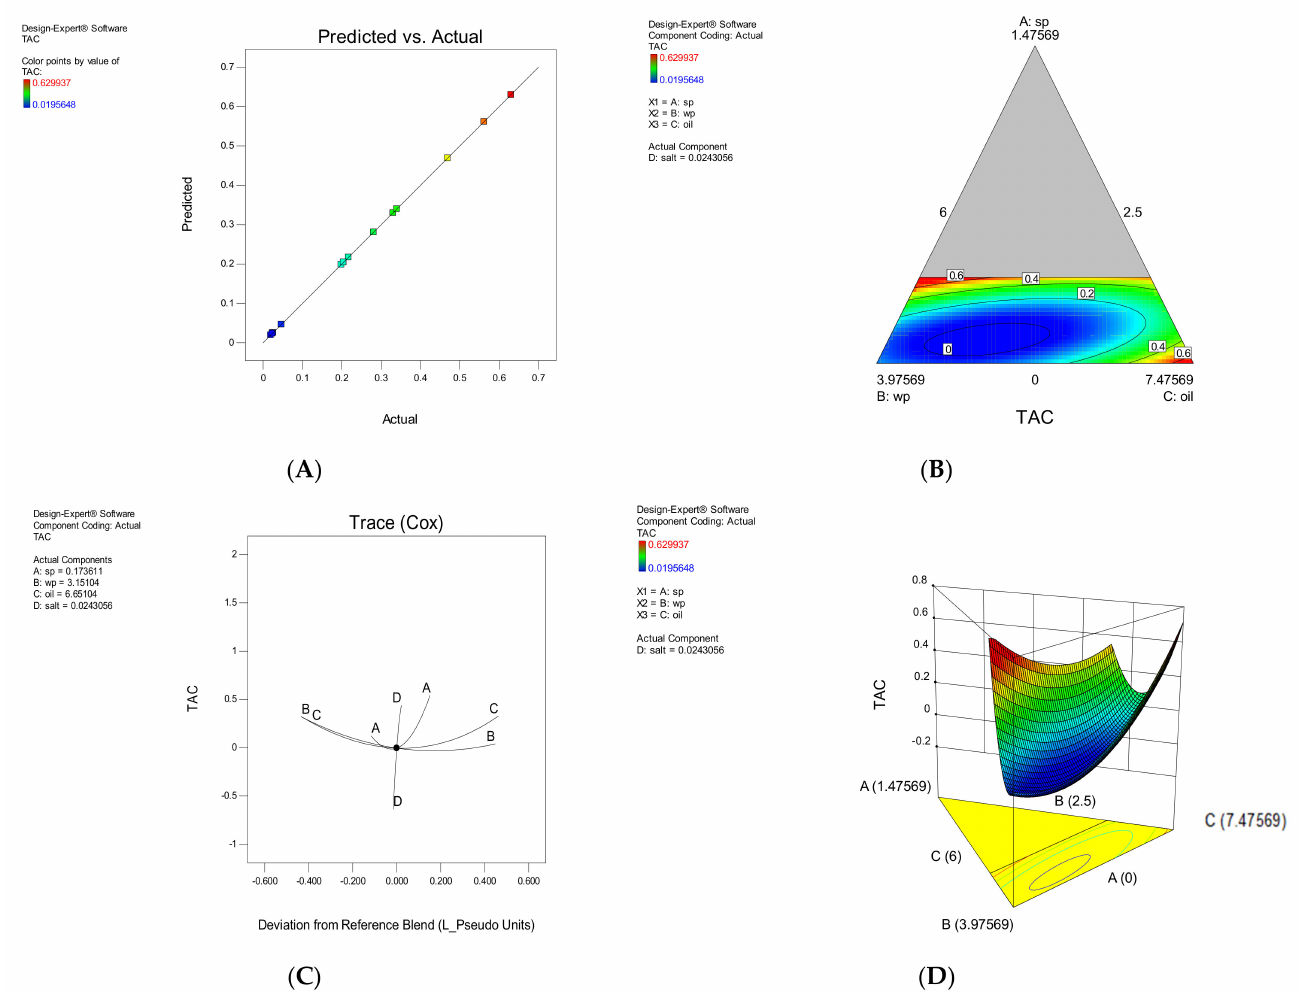
Figure 2. The effect of each parameter on Total anthocyanin compounds (TAC). The correlation be- tween experimental and approximated values ( A ), Contour plot ( B ), Trace plot ( C ), three-dimensional response surface plot ( D